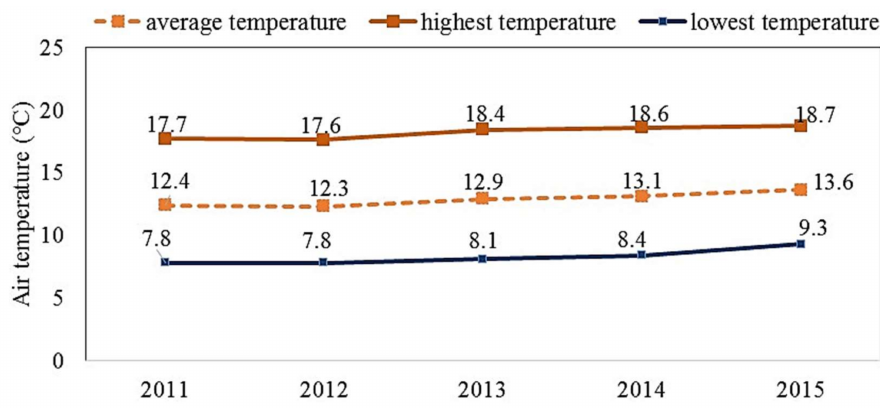
Figure 7. Comparison of annual